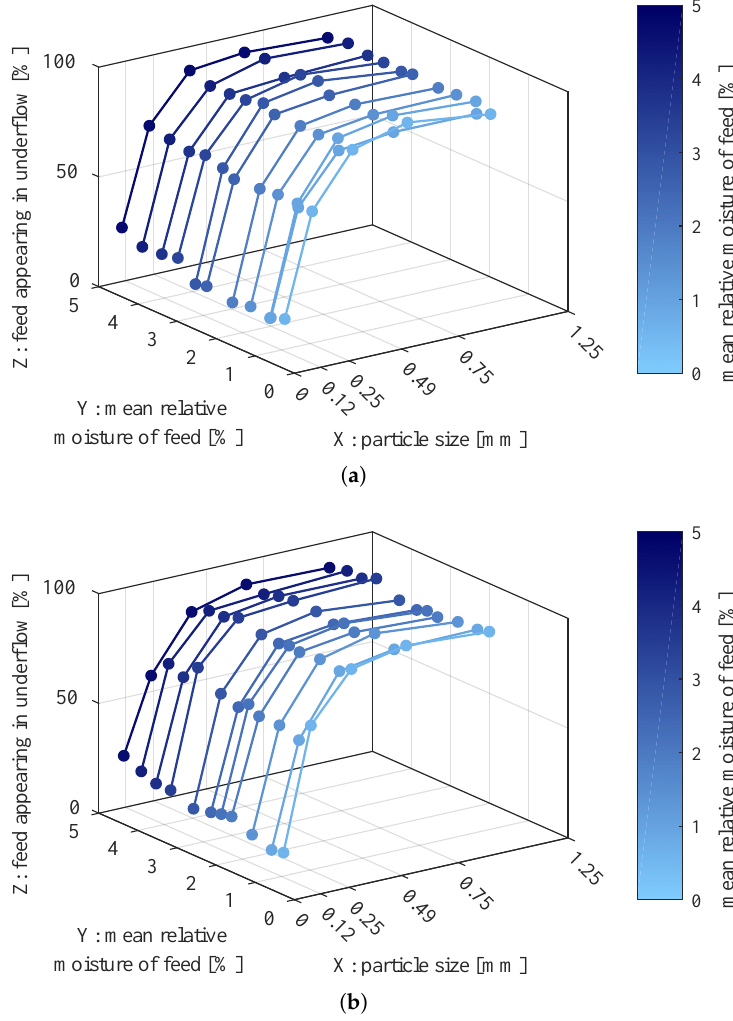
Figure 5. Partition curves for separator fed with material of varying moisture content. The material was supplied at: ( a ) 50%, ( b ) 100% of nominal throughput of the screw feeder. Each partition curve (seen as the XZ cross-section of the 3D plot) had the usual shape obtained for impingement-inertial classifier, i.e., it could be approximated by Weibull distribution [26] or scaled arctangent function [1]. This suggests that operating condi- tions of the separator were correct during the experiments and that sieve analysis was properly